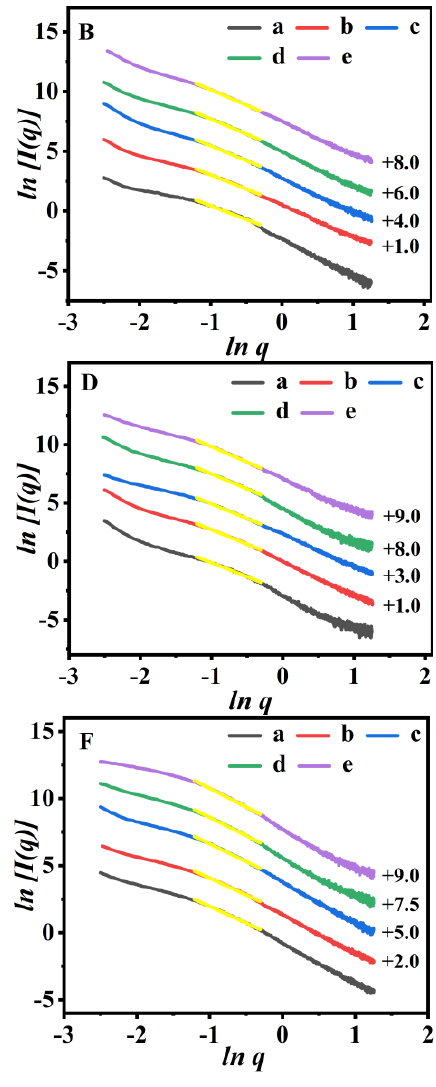
Figure 6. SAXS patterns (yellow lines were fitting curves based on the power low) of the swollen/shrunken ( A , B ) P(NA- AA)−0−0.1 , ( C , D ) P(NA- AA)−0−1 , and ( E , F ) P(NA- AA)−0−10 under pH 7.4 ( A , C, and E ) and 2.0 ( B , D, and F ) with the extended time. (a) 1 h, (b) 3 h, (c) 5 h, (d) 8 h, and (e) 24 h. The vertical offset values were presented in the right y -axis.